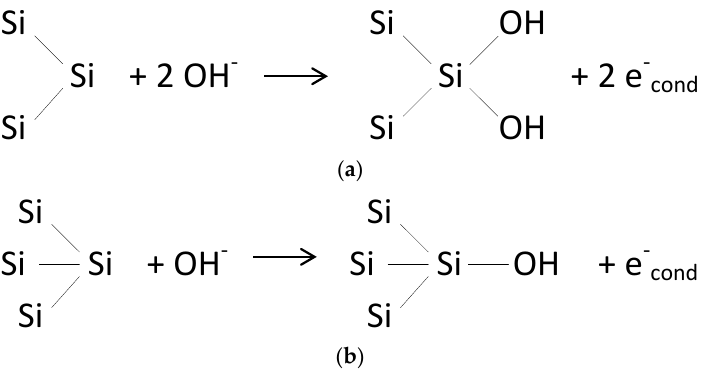
Figure 1. Schematic diagram representing the chemical structure of: surface and respective binding of hydroxide ions during a wet etch process for ( a ) (100) and ( b ) (111) silicon wafers. Anisotropy is achieved in different crystalline orientations since structural variations are present at the superficial atoms. For a (111) oriented plane, as depicted in Figure 1b, only one dangling bond exists for each superficial atom, thus making it harder to be etched when comparing with a (100) oriented plane, as in Figure 1a [8].